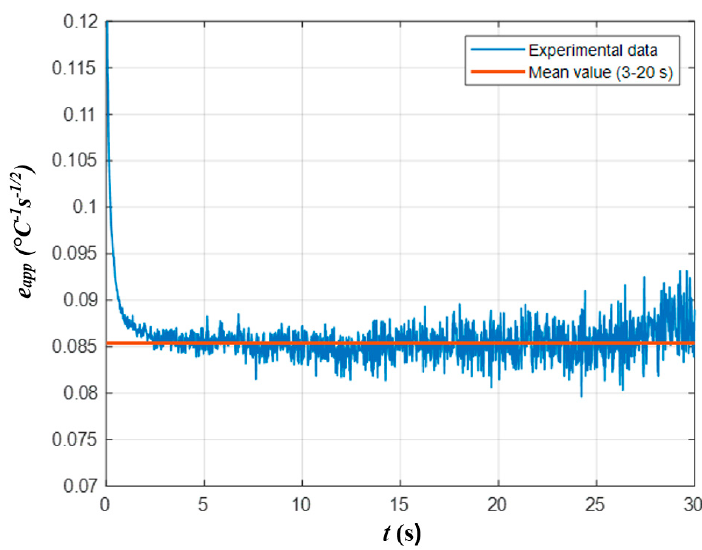
Figure 10. Apparent effusivity vs. time (PAL sample).